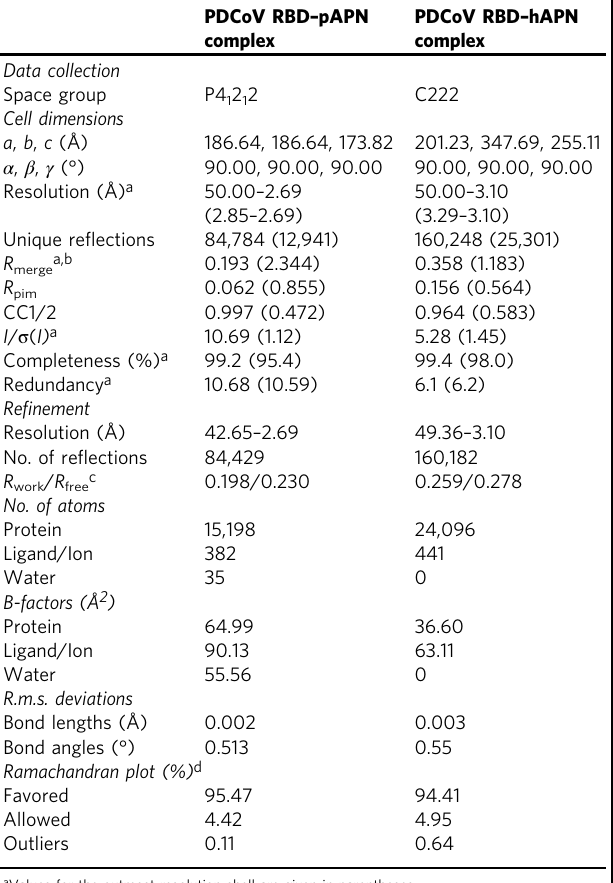
Table 1 X-ray crystallographic data collection and re fi nement